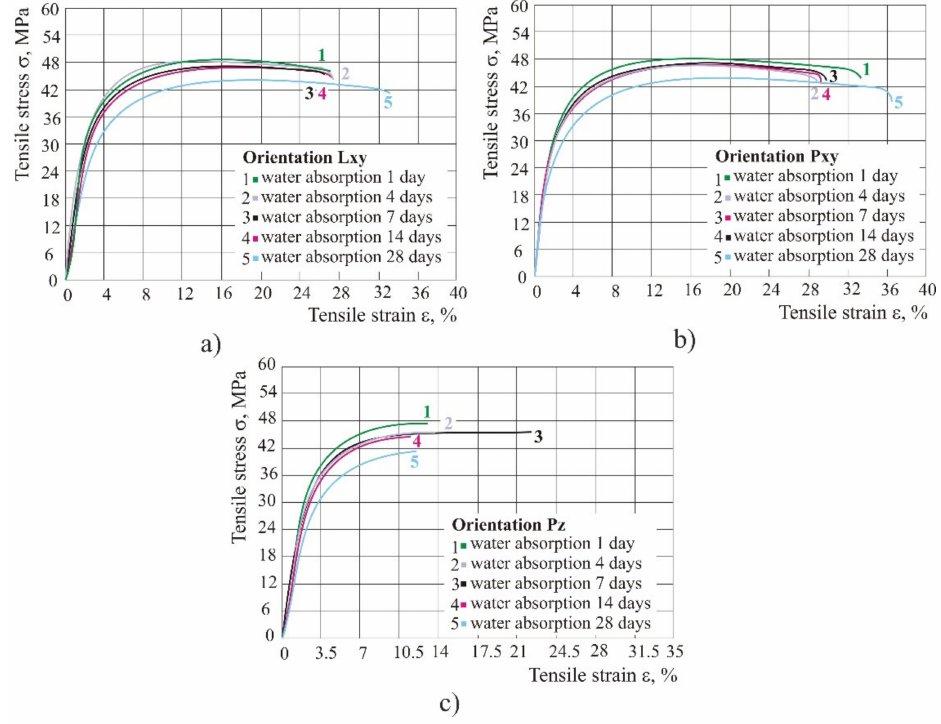
Figure 7. Diagram of tensile stress–strain in the case of water absorption: ( a ) orientation Lxy, ( b ) orientation Pxy, ( c ) orientation